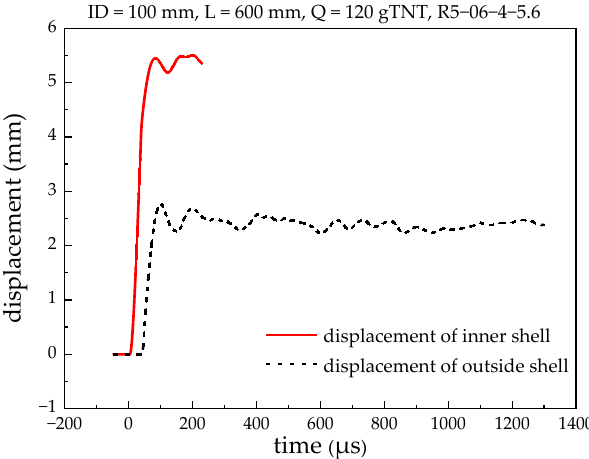
Figure 6. Displacement of double-layer shells measured by PDV.